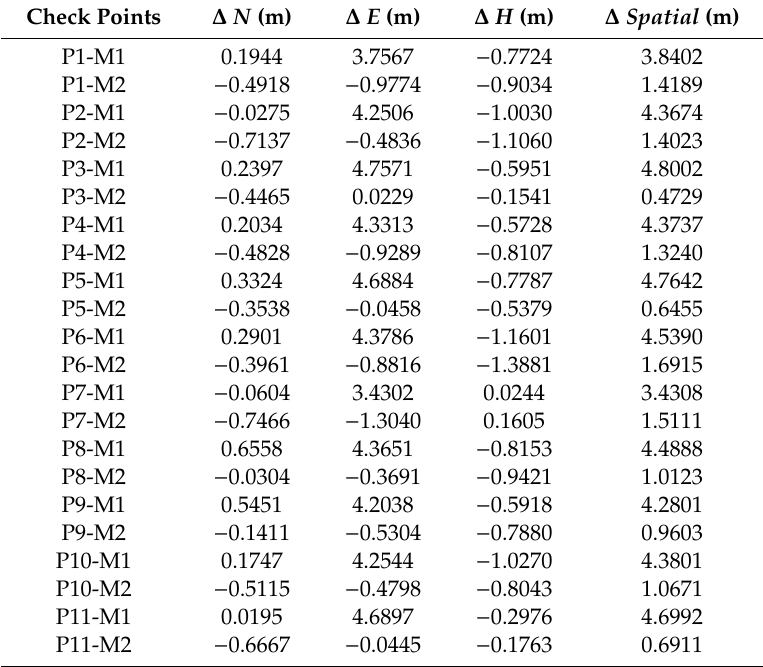
Table 3. The geolocation accuracy for the street lights and the street